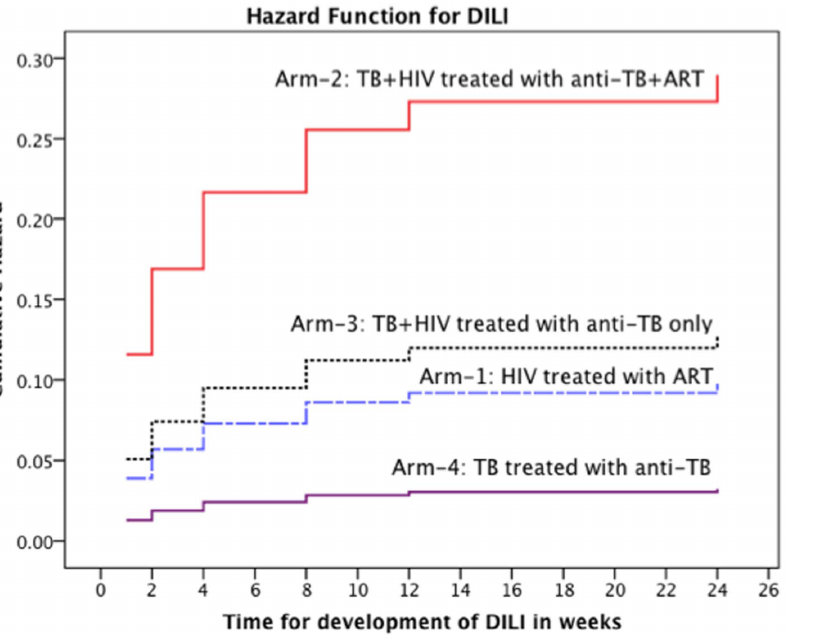
Figure 3. Kaplan–Meier curves to estimate cumulative hazard for the development of DILI stratified by type of treatment groups: HIV patients without TB co-infection (Arm-1) treated with efavirenz based HAART alone, TB-HIV co-infected patients with CD4 count # 200 cells/ m L treated with concomitant anti-TB and HAART therapy (Arm-2), TB-HIV co-infected patients with CD4 count . 200 cells/ m L treated with anti-TB therapy alone (Arm-3) and TB patients without HIV co-infection treated anti-TB therapy alone (Arm-4).